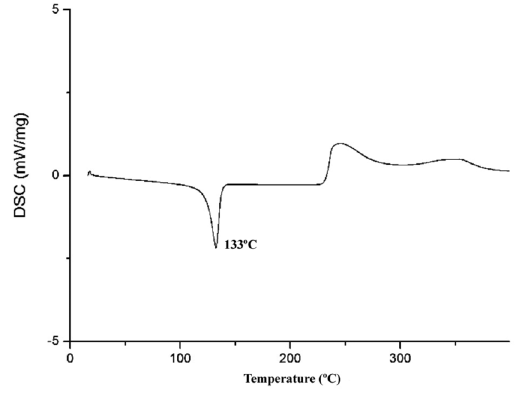
Figure 3. Differential Scanning Calorimetry (DSC) analysis of recycled HDPE.